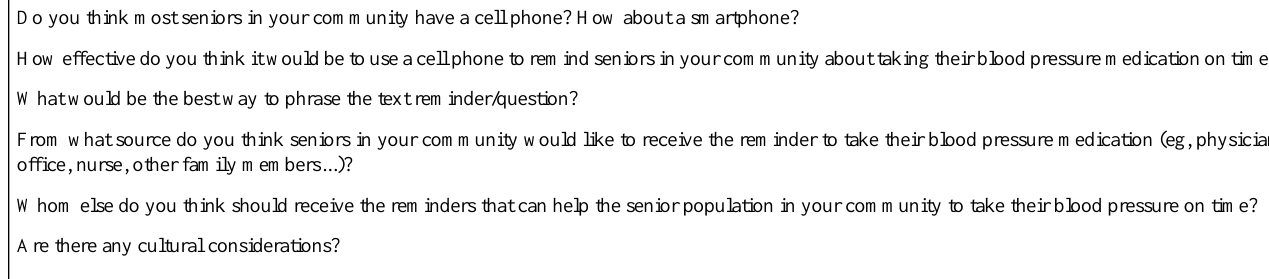
Textbox 1. Main questions from the semistructured key informant